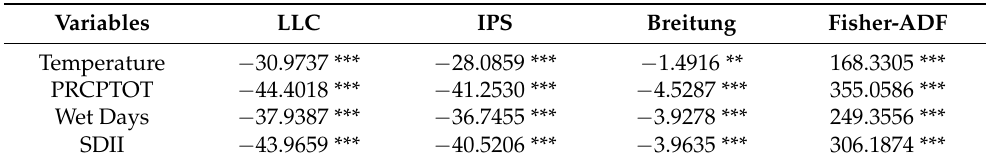
Table 3. Unit root